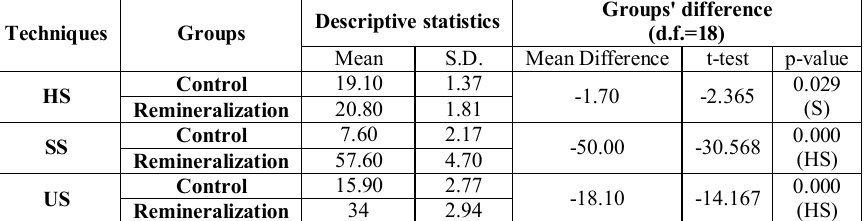
Table 2: Effect of re-mineralization on Enamel damage depth (μm.) and comparing the effect of re-mineralization with the control group